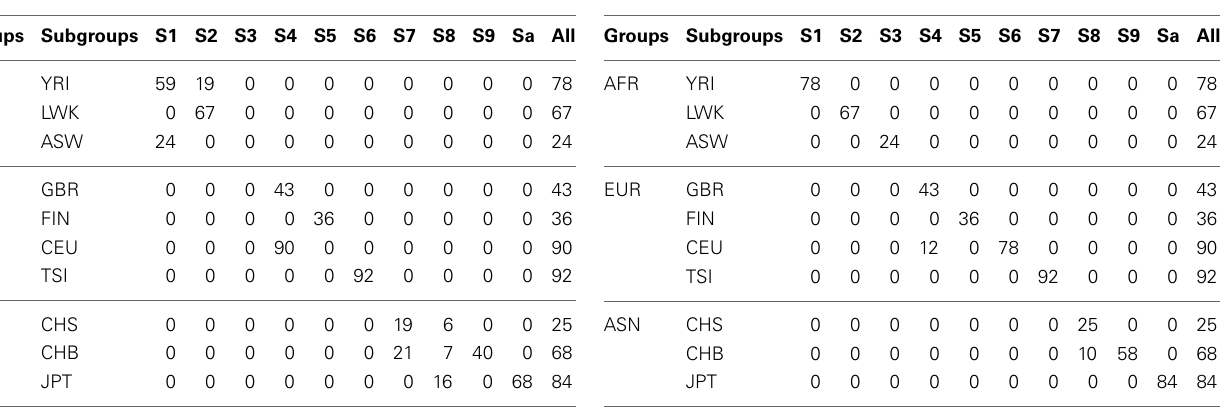
three sub-figures demonstrate comparison of Lasso, Ridge and SSSC for the cases that semi-supervised information involves all the four subgroups, while the bottom three for the cases that semi-supervised information involves two subgroups.